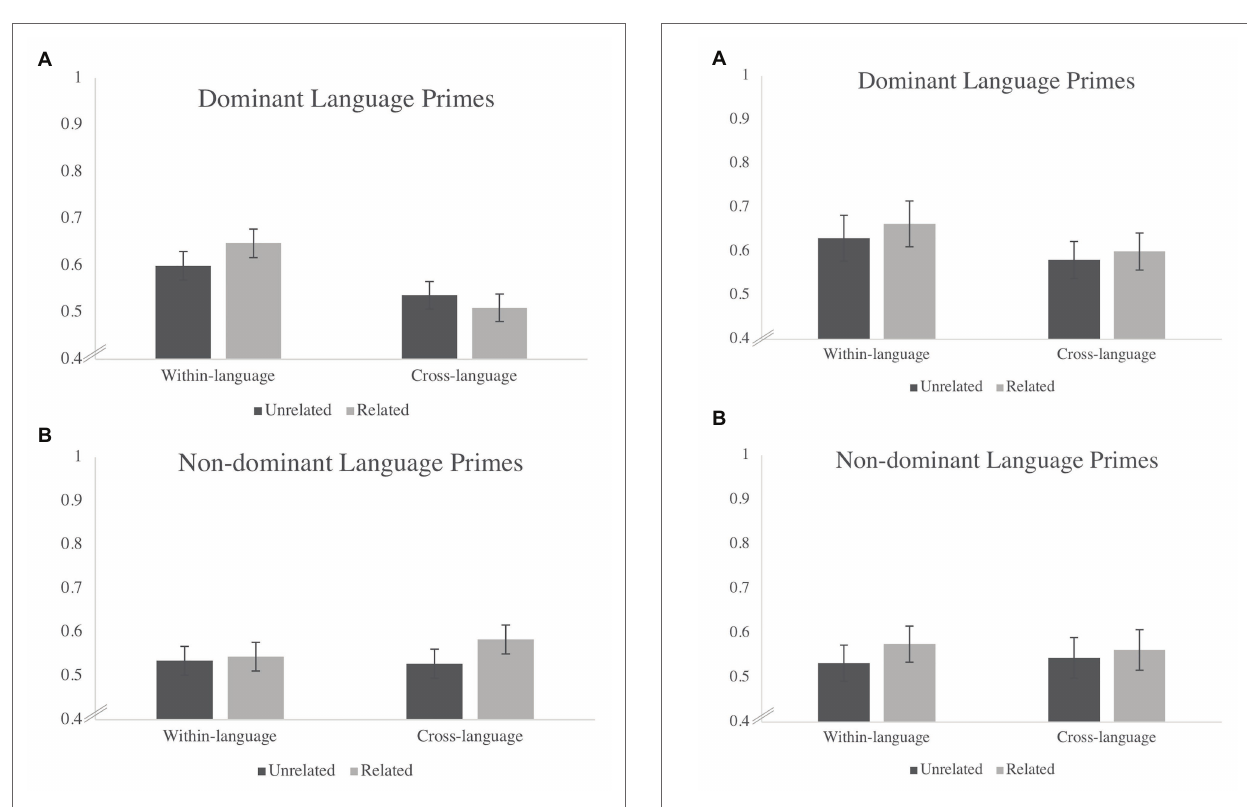
FIGURE 3 | Average proportion of time spent looking at the target across related and unrelated trials at 18 months when primes were in the (A) dominant language compared to the (B) non-dominant language across within- and cross-language blocks.